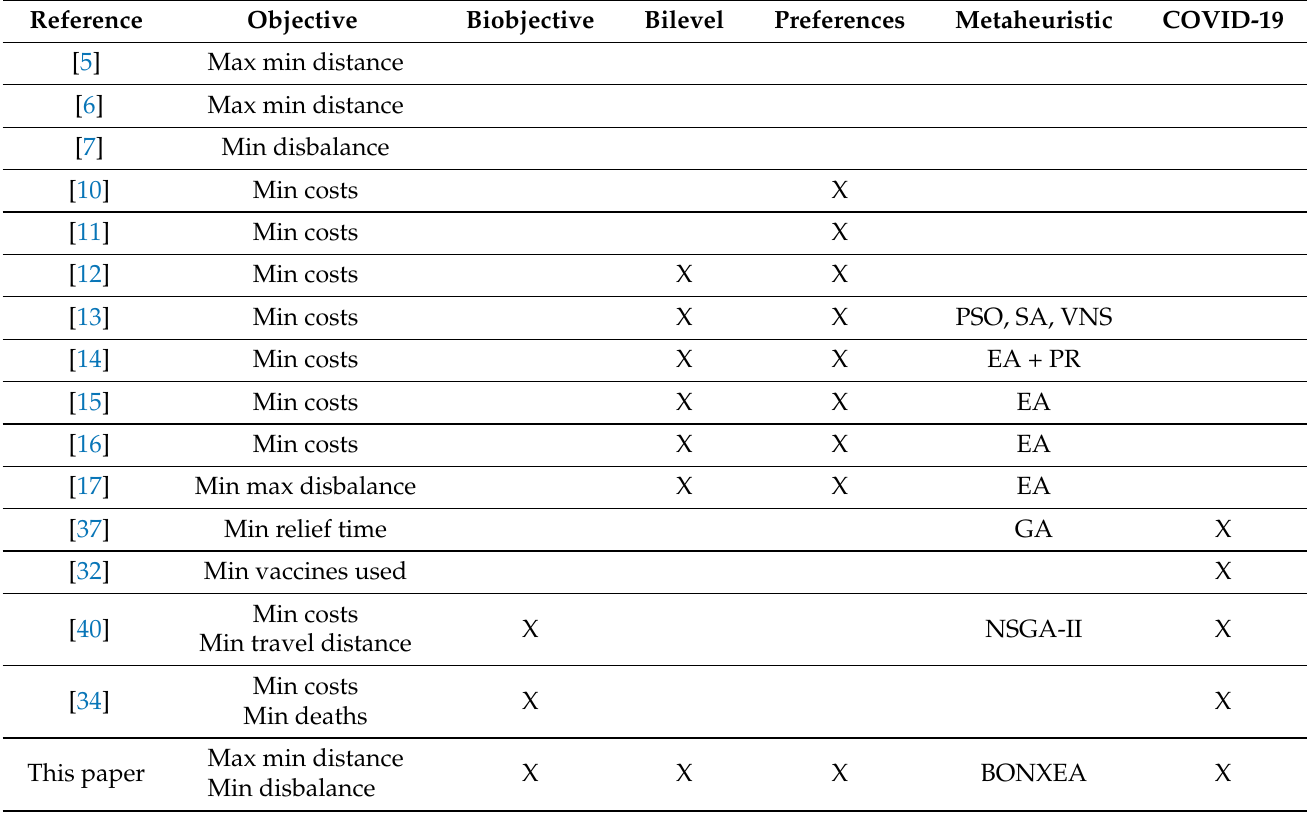
Table 1. Summary of the characteristics considered in the closely related